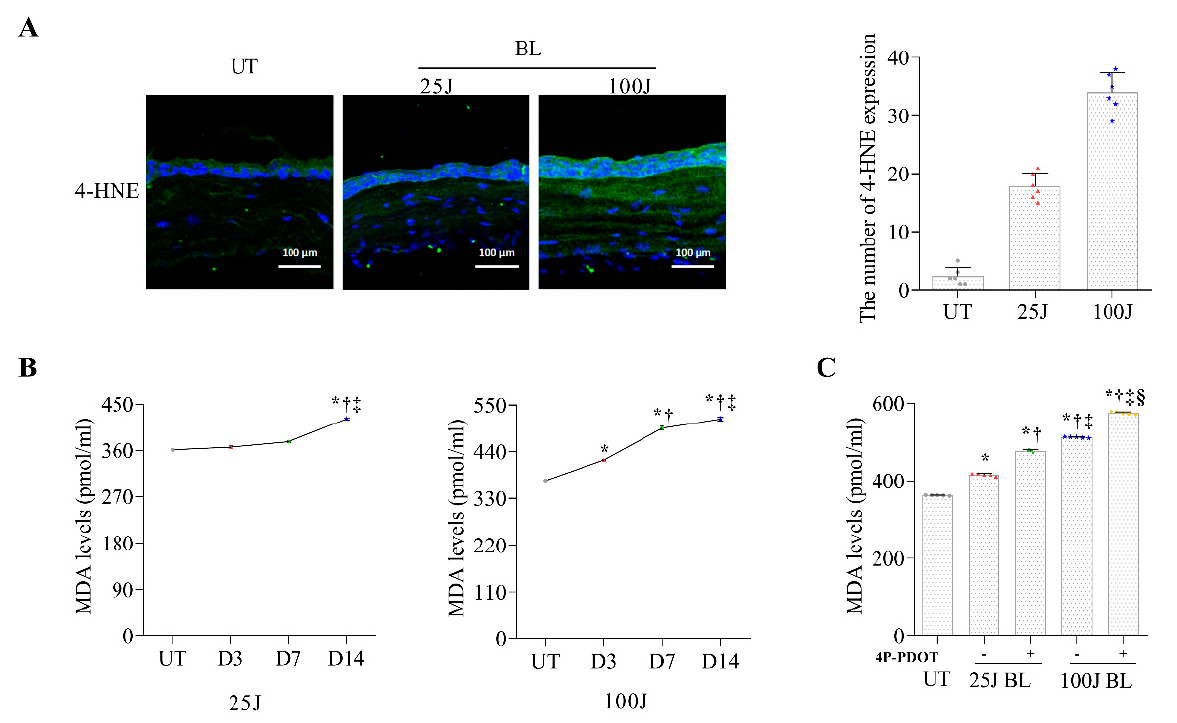
Figure 1. Showing representative photograph and the mean number of 4-HNE expression by IHC ( A ) in the cornea of the UT, 25 J BL, and 100J BL groups, after 14 days of BL exposure. ELISA for MDA ( B ) in the cornea of the UT, 25 J BL, 25J BL+4P-PDOT, 100 J BL, and 100 J BL+4P-PDOT groups. ( B ) * p < 0.05 vs. UT, † p < 0.05 vs. D3, ‡ p < 0.05 vs. D7; ( C ) * p < 0.05 vs. UT, † p < 0.05 vs. 25J BL, ‡ p < 0.05 vs. 25J BL+4P-PDOT, § p < 0.05 vs. 100 J BL; UT, untreated; BL, blue light.